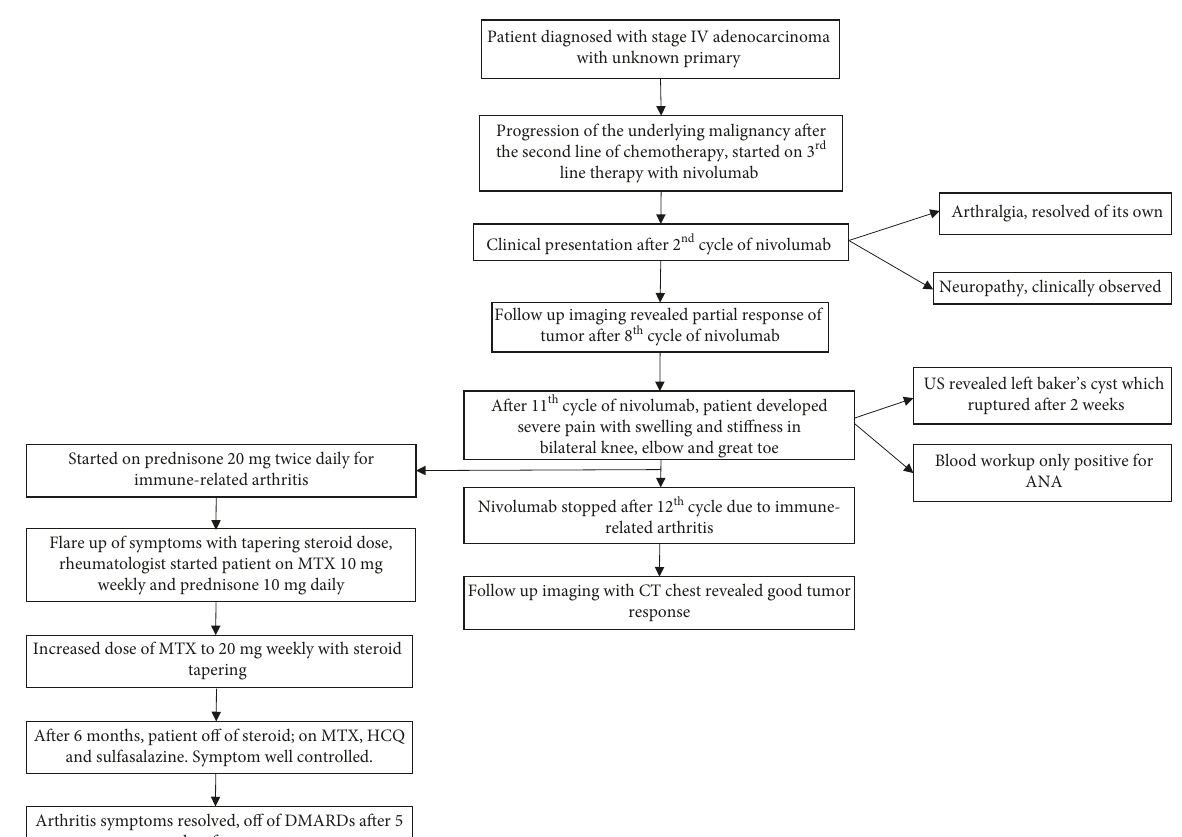
Figure 4: Flowchart illustrating the complete clinical course of the patient. ANA: antinuclear antibody, US: ultrasound, MTX: methotrexate, HCQ: hydroxychloroquine, DMARDs: disease-modifying antirheumatic drugs.